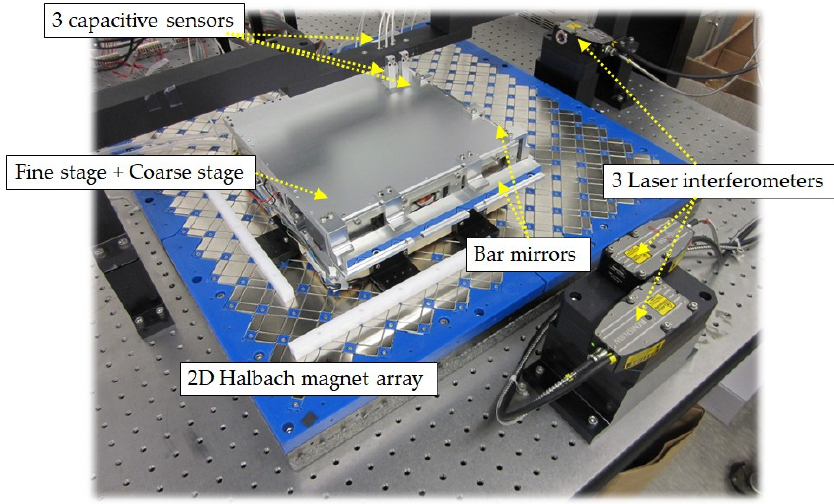
Figure 8. The realized dual servo maglev stage system.